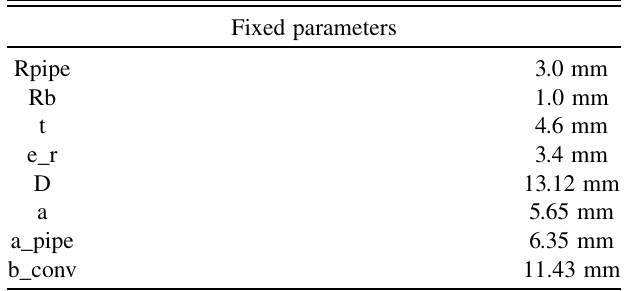
TABLE II. Tuning parameters for PBG-E structure. Final de- sign values for Fig. 3(b).